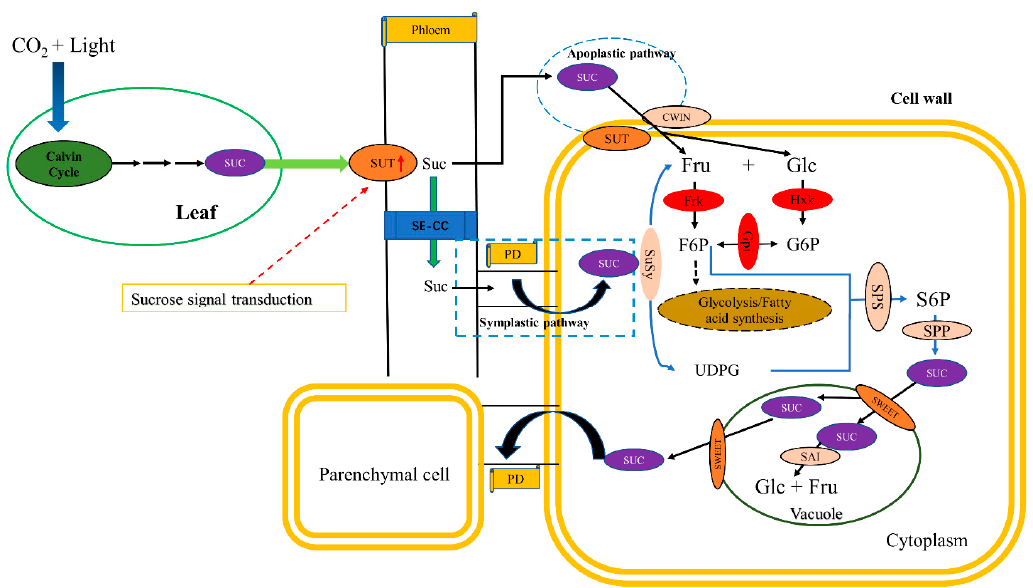
Figure 8. Hypothetical model of sucrose synthesis, transport, and metabolism in C. oleifera fruit development. Sucrose is synthesized in leaves and initiates signal transduction which induces SUT expression. Sucrose molecules are loaded in the phloem and enter sink cells by two different transport pathways: symplastic and apoplastic. Changes in sucrose content are controlled under the combined action of sucrose synthesis and invertase in different developmental stages. SUC: sucrose; SUT: sucrose transporter; SE/CC: sieve element/companion cell; PD: plasmodesmata; CWIN: cell